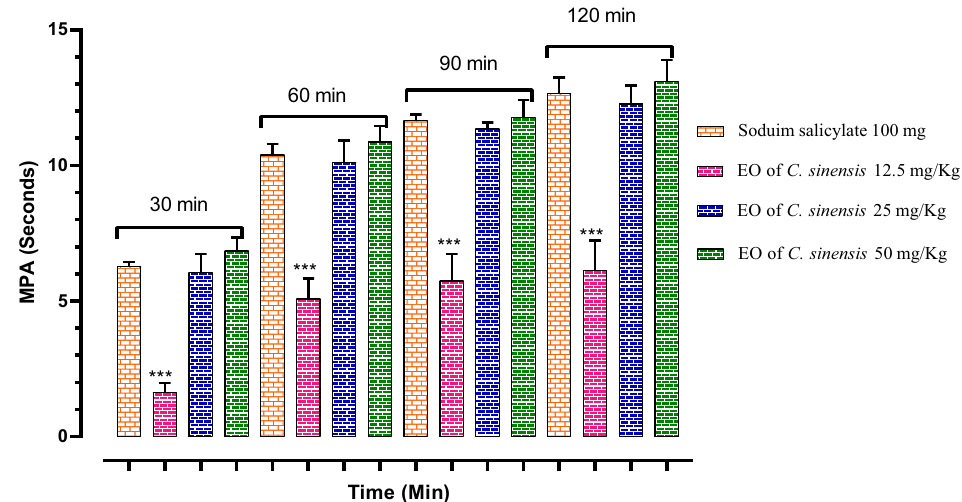
Figure 3: E ff ect of C. sinensis essential oil on the antinociceptive e ff ect of the hot plate. The values compared with positive control are expressed as mean ± SD ( n = 5 ) . *** P < 0.001.